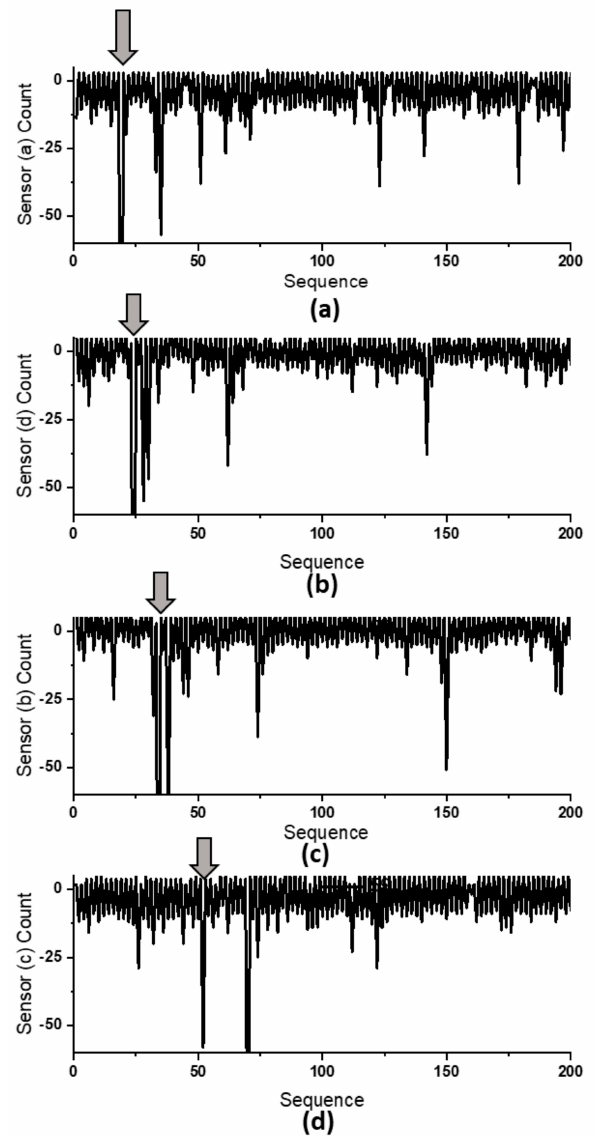
Figure 9. Accumulated working/non-working count for sensors ( a – d